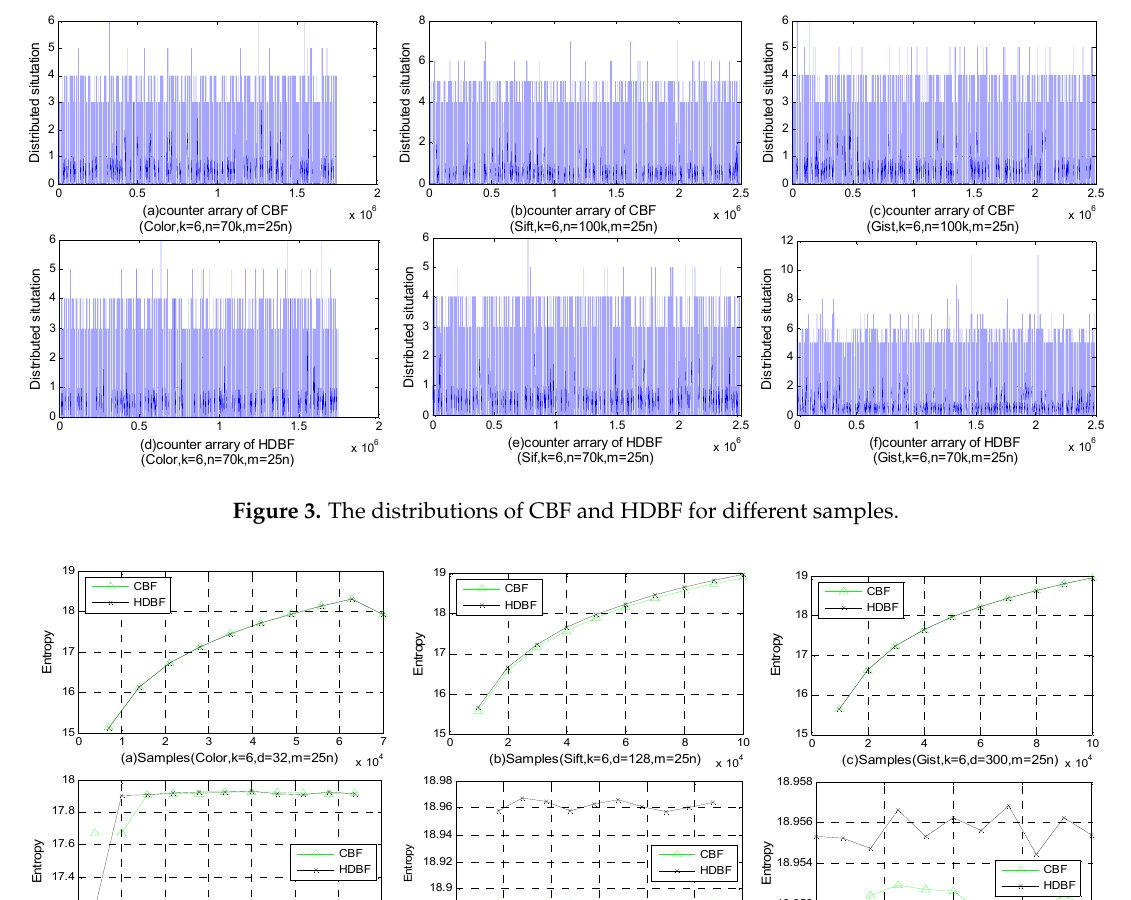
Figure 4. Entropies of CBF and HDBF for different samples.